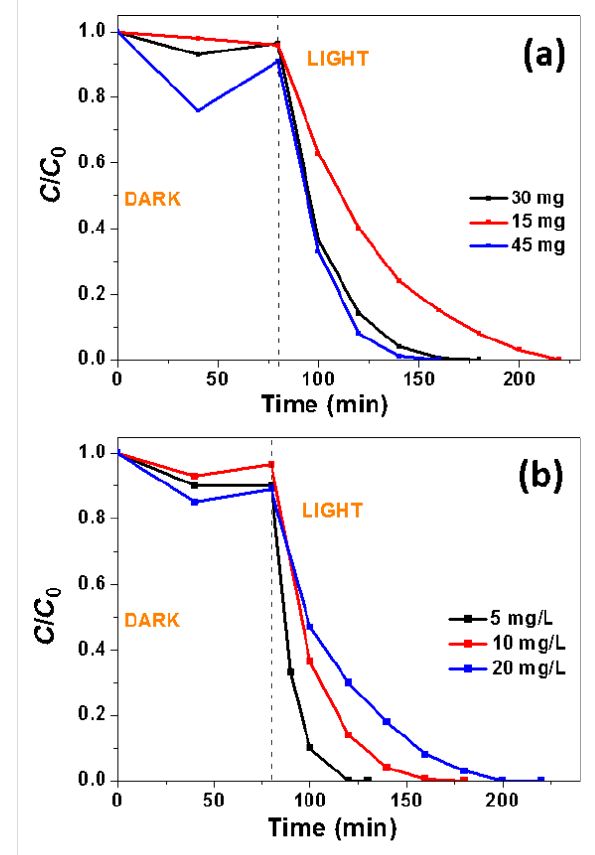
Figure 9: Influence of the pH of the Orange II solution on the photocat- alytic activity of 5% Ce-doped ZnO rods.